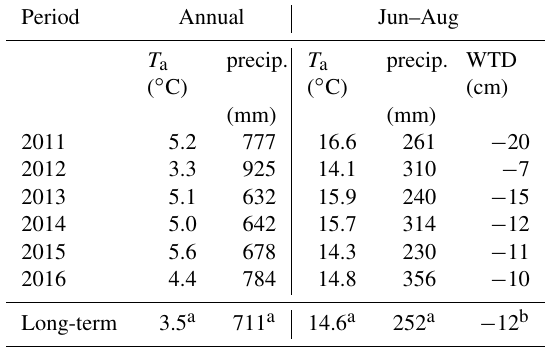
Figure 5. Time series of measured and modeled 30min values of NEE, Re, GPP and F CH (May–September). The model CH 4 flux 30min values are mostly hidden under the daily mean markers. Table 4. Average annual and summer air temperature, precipitation and water table depth in comparison with 30-year